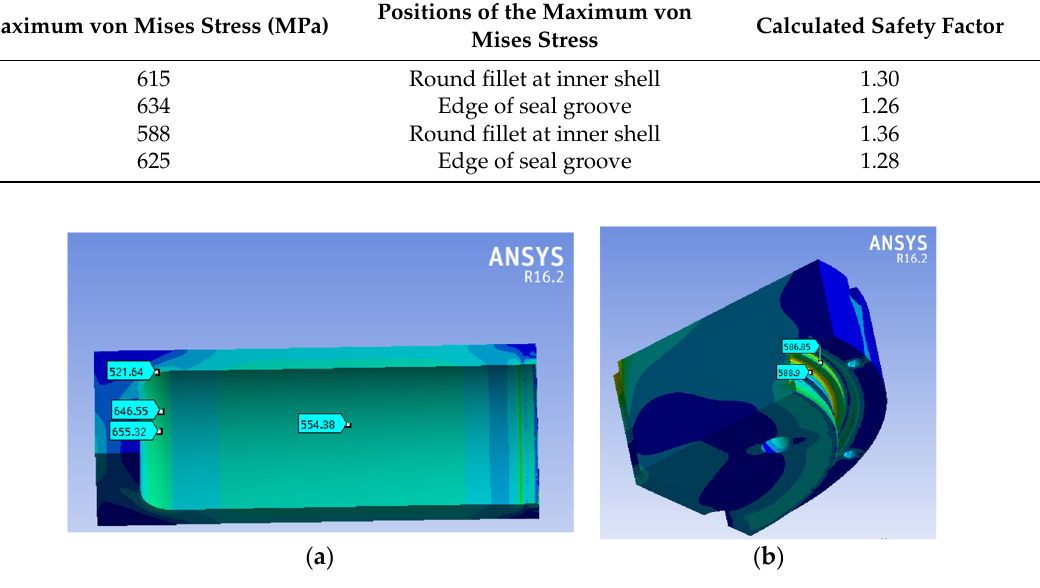
Figure 9. ( a ) The von Mises stress cloud map of the hull; ( b ) the von Mises stress cloud map of the